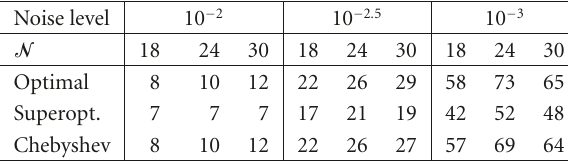
Table 3: Number of iterations for all the methods. Mask 1, with